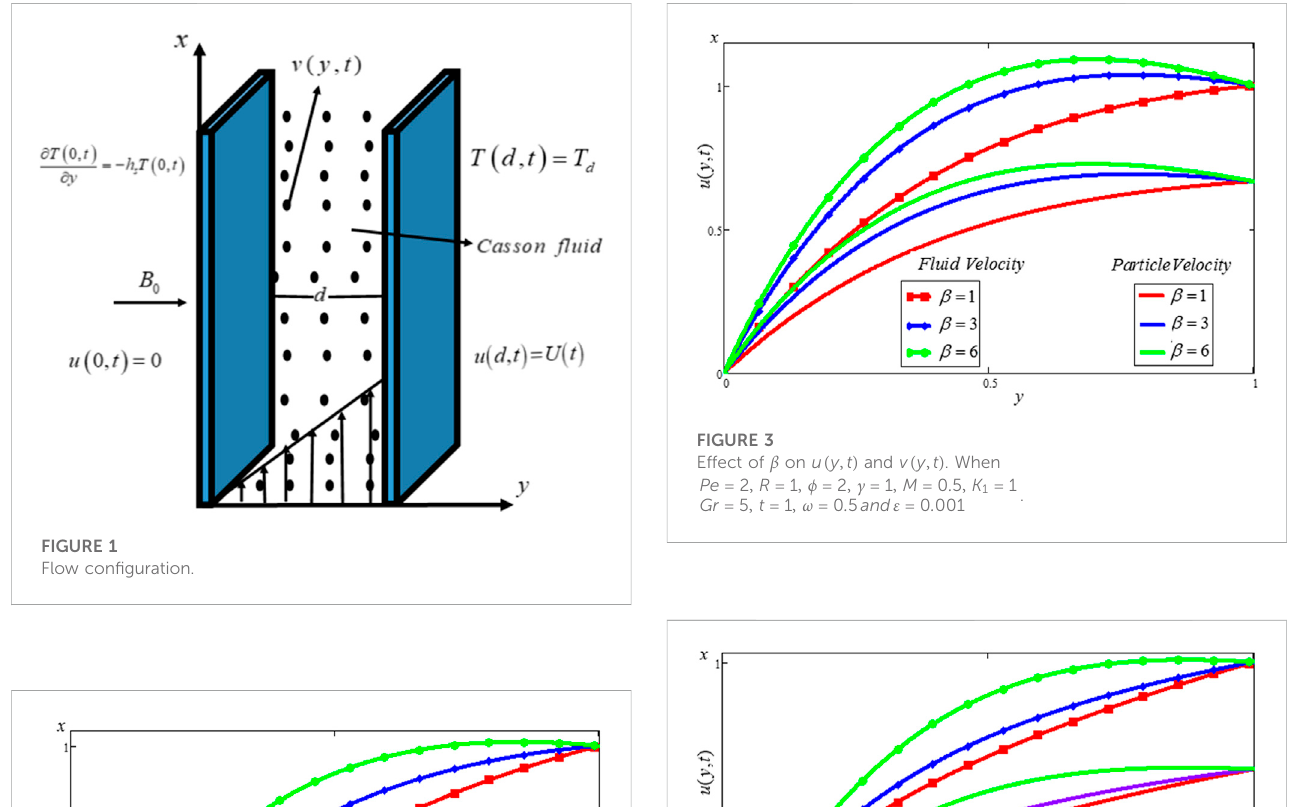
FIGURE 4 Effect of ϕ on u ( y , t ) and v ( y , t ) . When Pe (cid:2) 2 , R (cid:2) 1 , ϕ (cid:2) 2 , γ (cid:2) 1 , M (cid:2) 0 . 5 , K Gr (cid:2) 5 , t (cid:2) 1 , ω (cid:2) 0 . 5 and ε (cid:2) 0 . 001